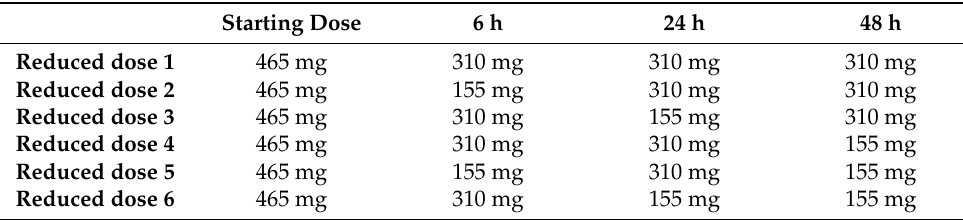
Figure 6. Predicted drug concentration for the healthy population under original dose, rheumatoid arthritis (RA) population under original dose, and RA population under Reduced dose 1, 2, 3, and 4. Table 2. Details of Reduced dose 1, 2, 3, 4, 5, and